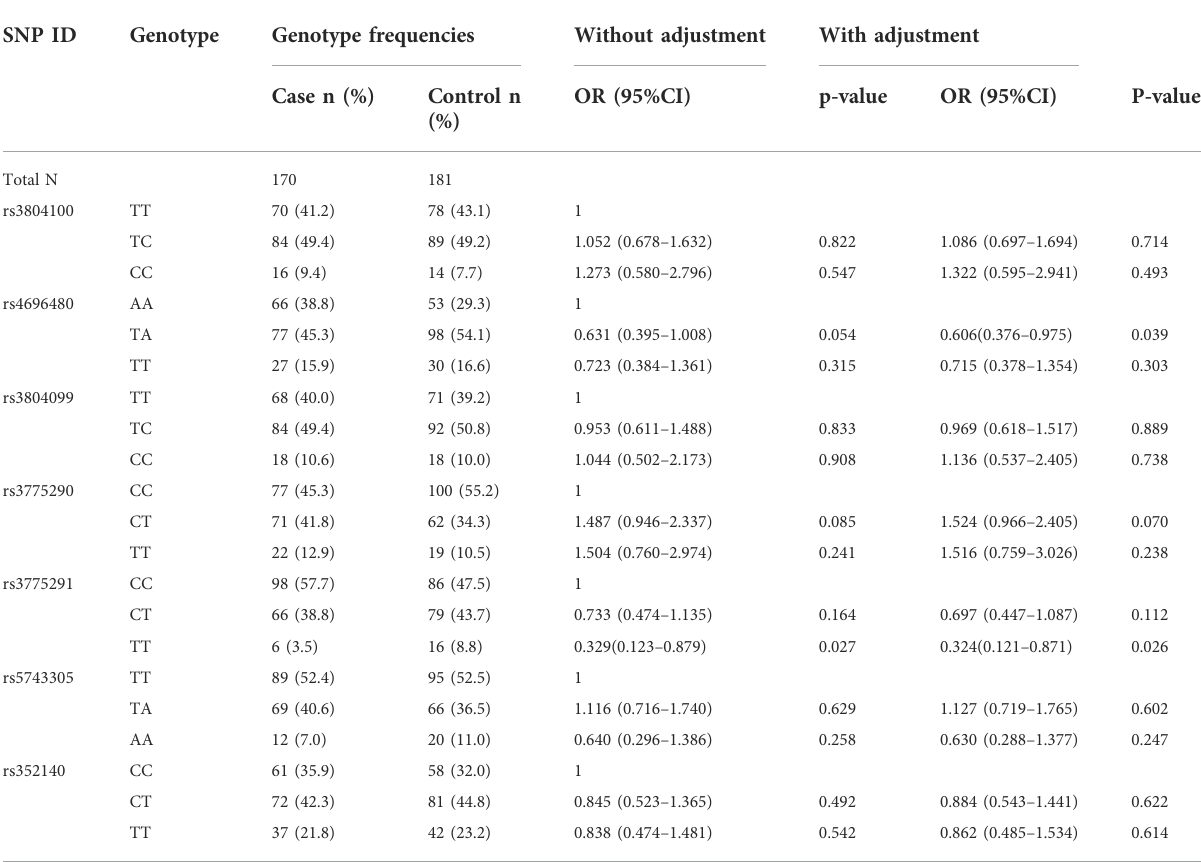
TABLE 4 Genotypes frequencies of the SNPs and their associations with risk of COPD